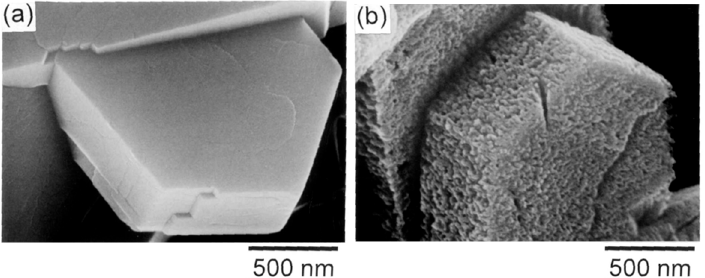
Figure 2. Desilication method: ( a ) SEM image of standard ZSM-5 and ( b ) SEM image of the ZSM-5 sample after alkaline treatment [11]. Copyright (2000), with permission from The Chemical Society of Japan.